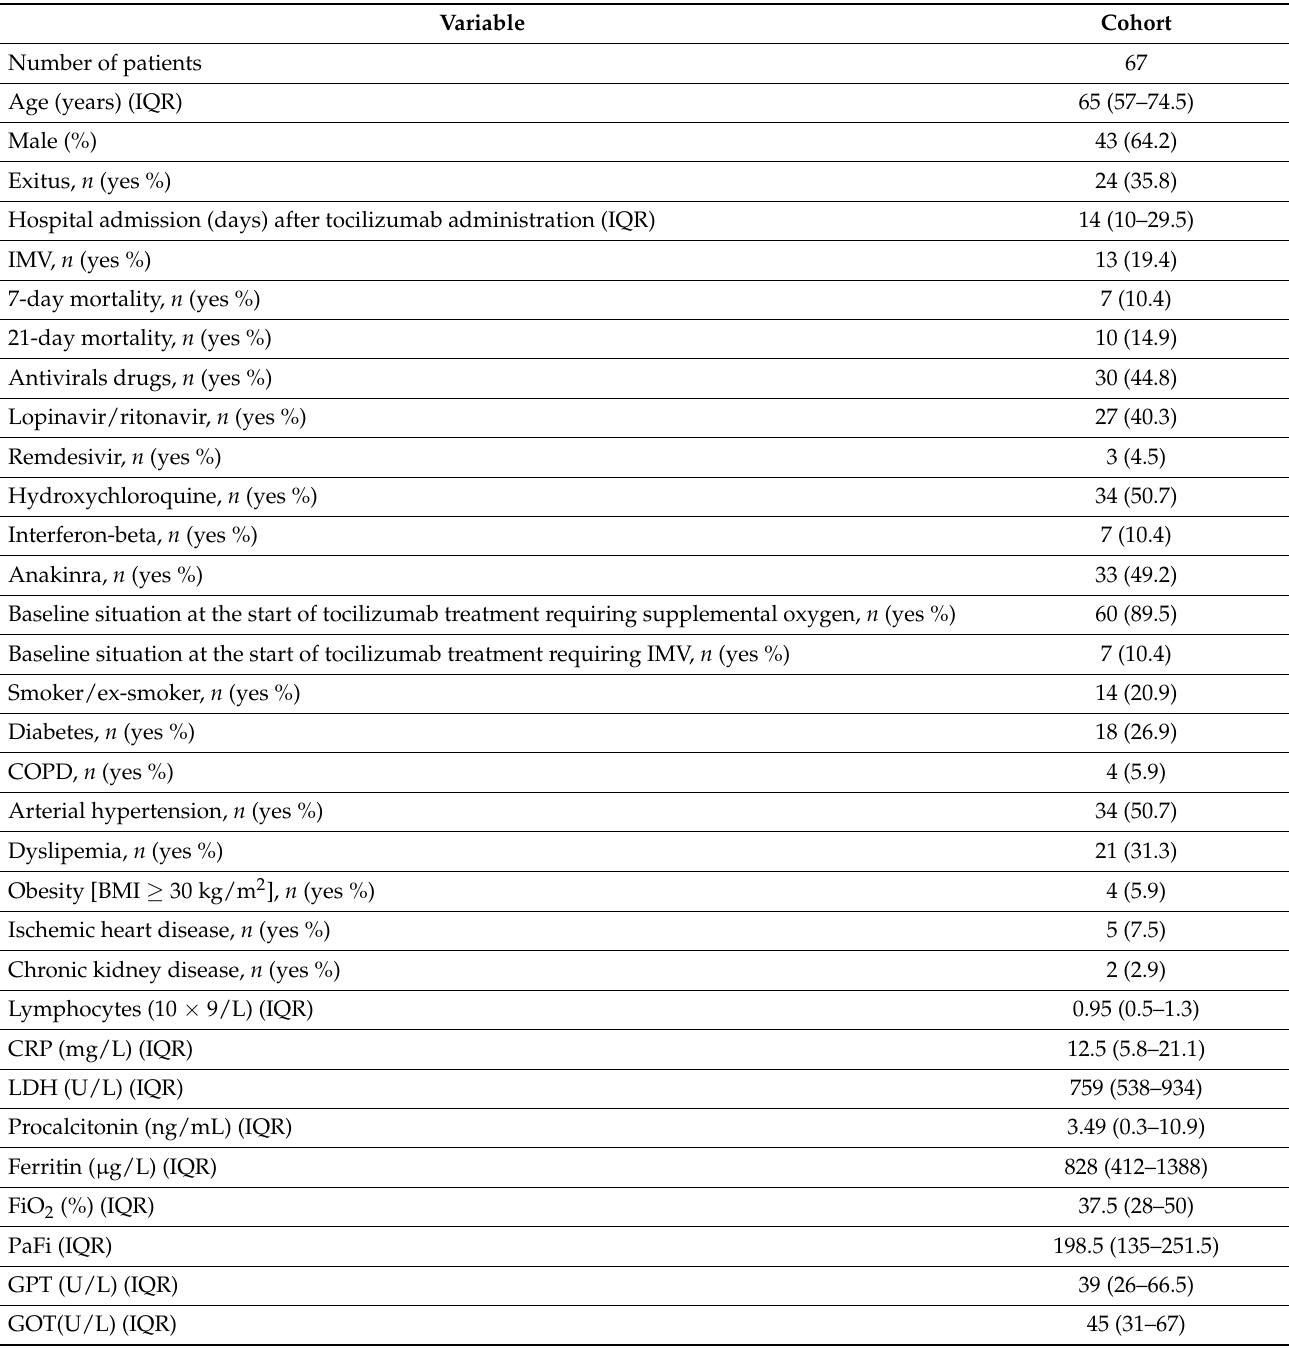
Table 3. Basal clinical data of patients. Data are n (%) or median (IQR), unless otherwise